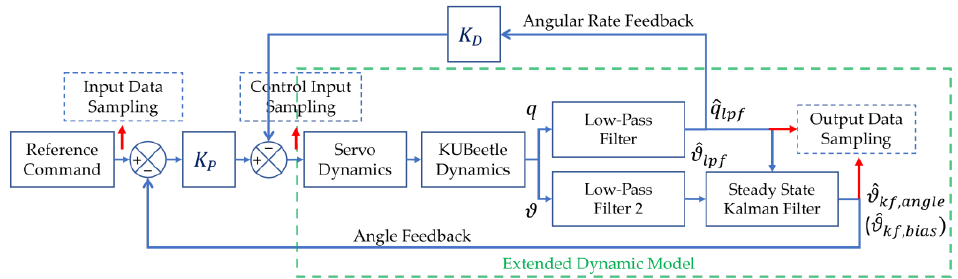
Figure 2. Data acquisition structure of system identification with a PD feedback controller.